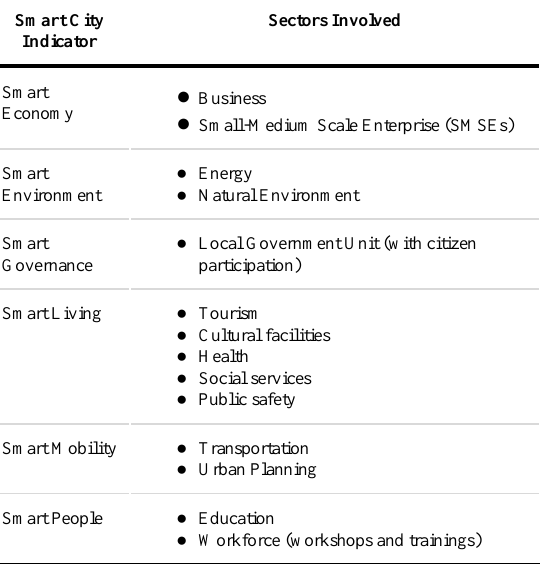
Table 5. Sectors involved in each smart city indicator. Based on the indicators of a smart city by Letaifa